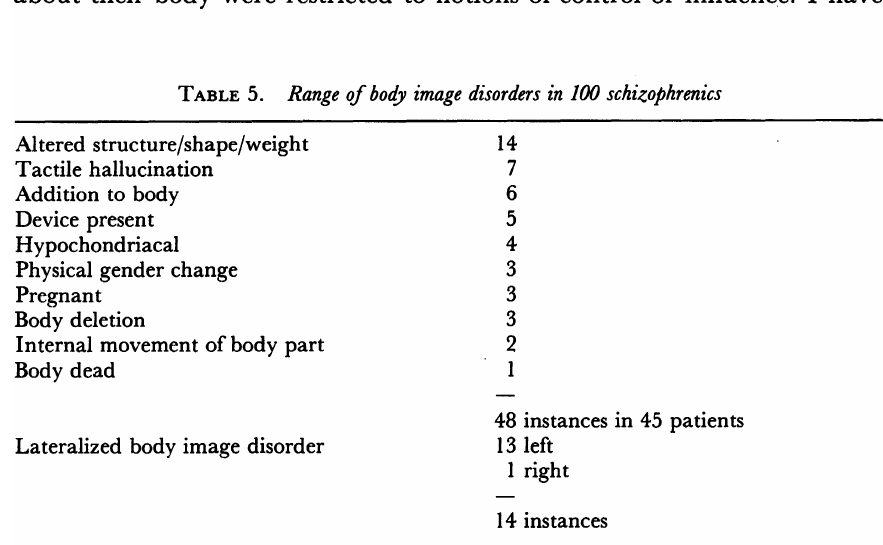
TABLE 5. Range of body image disorders in 100